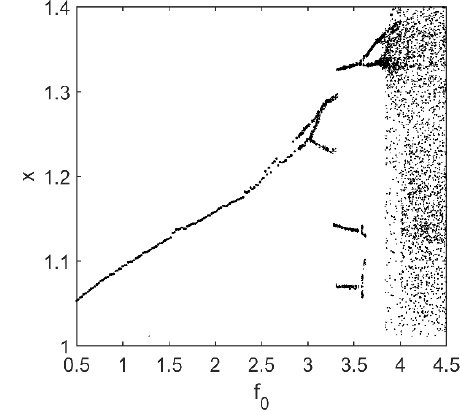
Figure 11. Bifurcation diagram under different values of f 0 .